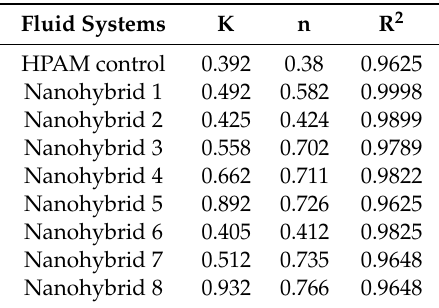
Table 3. Hershel–Bulkley law coe ffi cients and coe ffi cient of determination, R 2 , values for the HPAM polymer solution and the nanohybrid systems.